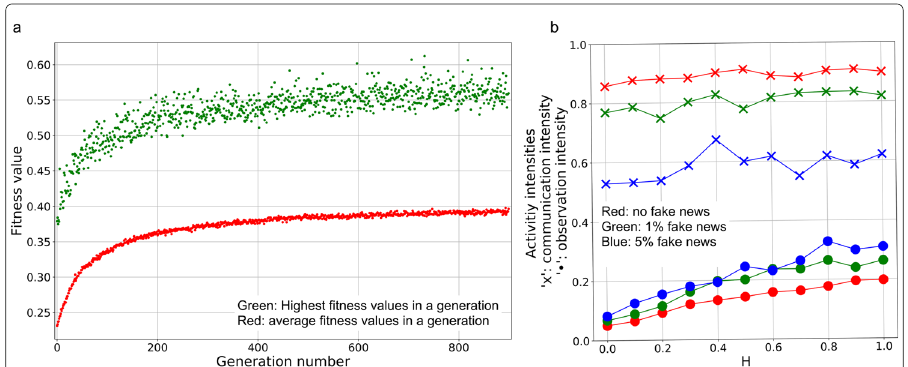
Fig. 6 The progress of the optimization ( a ) and the optimal activity values for extreme cost values ( b ). a The best (green dots) and the average (red dots) fitness values as a function of the generation number. Saturating fitness curve indicates that the chromosomes in the last generations are optimal solutions for the original problem. b Optimal activity values for as a function of H for C Comm = 0 and C Obs = 1. According to our results, exposure to fake news calls forth intensified observation and weakened communication activity. Observation activities in optimized groups – independently of the level of fake news – increase as a